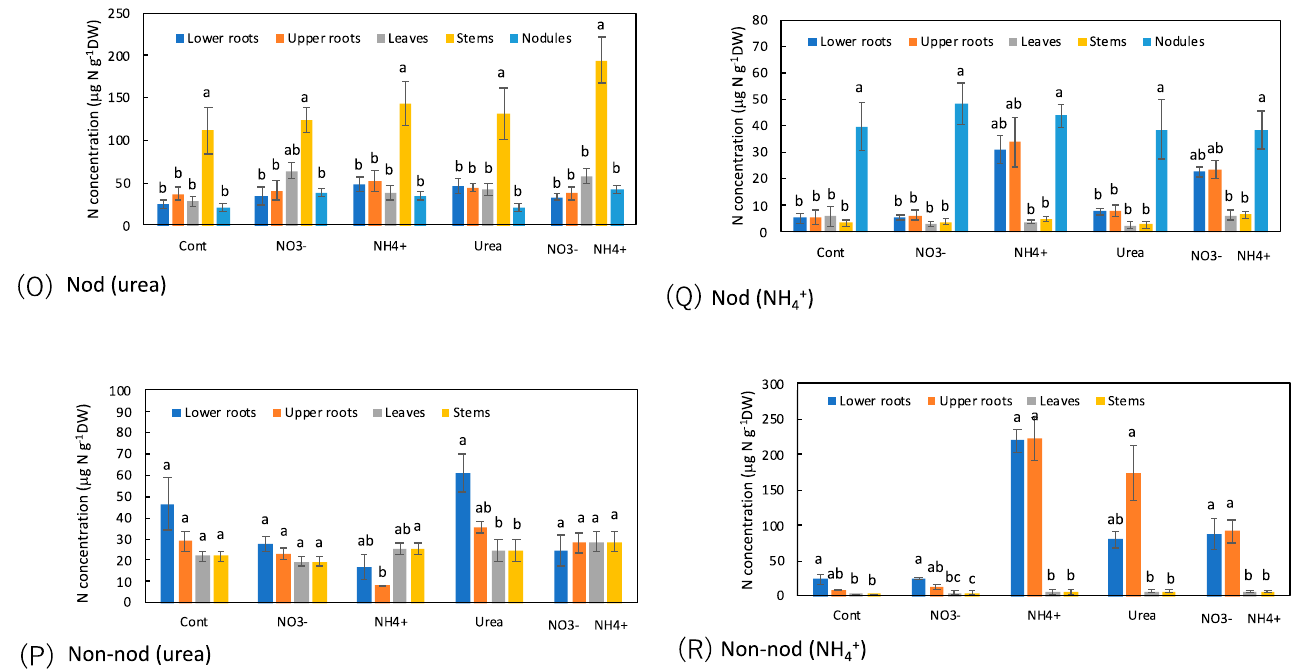
Figure 8. Comparison of the concentrations of N metabolites among the organs of the Nod and Non-nod soybean plants treated with the various N compounds: ( A , B ) NO 3 − ; ( C , D ) allantoate; ( E , F ) allantoin; ( G , H ) Asn; ( I , J ) Gln; ( K , L ) Asp; ( M , N ) Glu; ( O , P ) urea; ( Q , R ) NH 4+ . ( A , C , E , G , I , K , M , O , Q ) nodulated plants; (B,D,F,H,J,L,N,P,R) non-nodulated plants. Treatments: Cont, control with N-free solution; NO 3 − , 5 mM KNO 3 ; NH 4+ , 2.5 mM (NH 4 ) 2 SO 4 ; urea, 2.5 mM urea; and NO 3 − + NH 4+ , 2.5 mM KNO 3 + 1.25 mM (NH 4 ) 2 SO 4 . N = 3. Average ± standard error. Different letters on the top of the columns indicate significant differences in the N concentrations among the organs based on Tukey’s test ( p < 0.05).